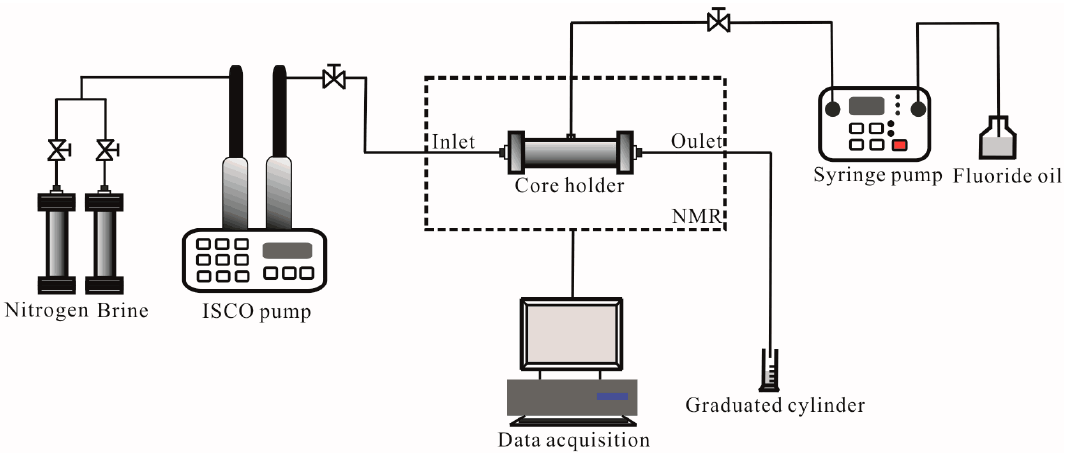
Figure 2. Experimental setup for the forced and spontaneous imbibition